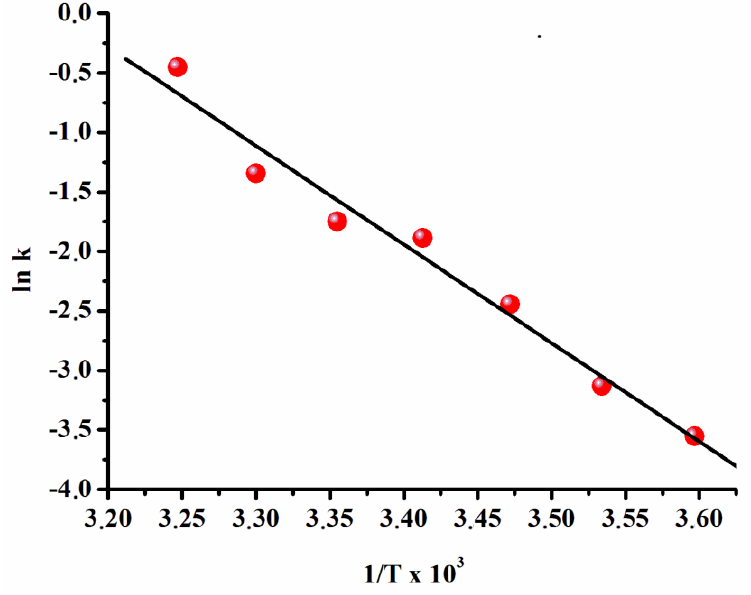
Figure 4. Arrhenius plot for the dihydrogen phosphate anion-stabilized ruthenium(0) NP-catalyzed hydrolysis of AB ([Ru] = 0.50 mM, [AB] = 100